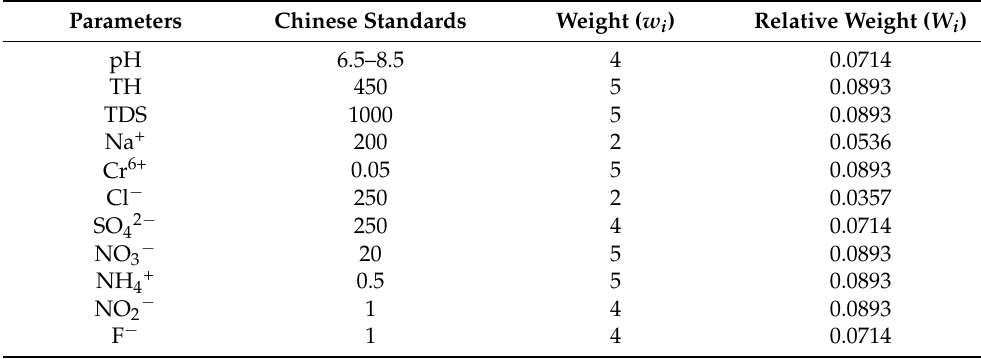
Table 4. Relative weight of physicochemical parameters. All units for all parameter indices are in mg/L, except pH